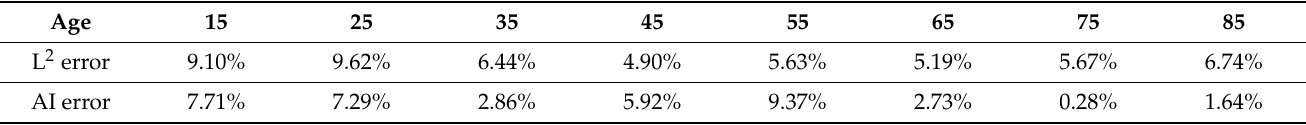
Table 1. Errors between human pulse pressure waveforms and artificial waveforms generated by 3D cam